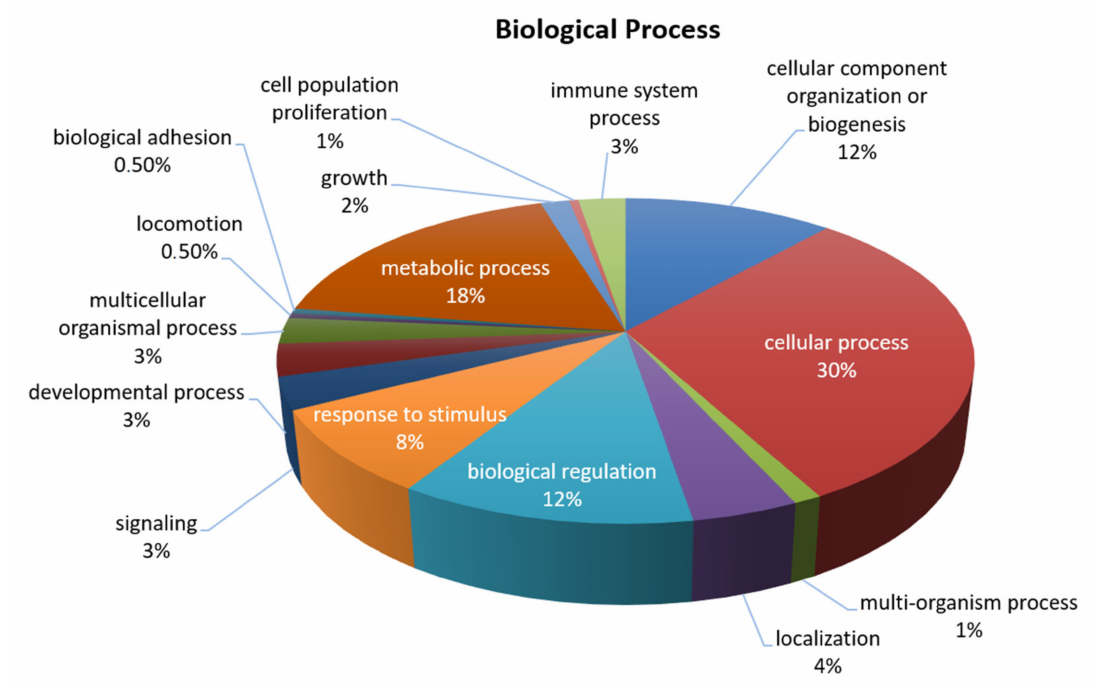
Figure 1. General biological processes involving the proteins detected in the OA SF-AC co-cultures secretome identified by SILAC. Protein classification was performed, using the PANTHER (protein analysis through evolutionary relation- ships)